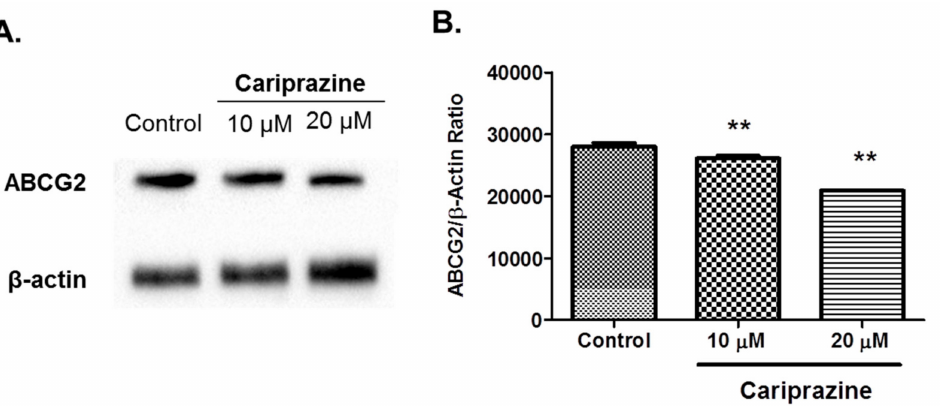
Figure 5. The effects of cariprazine on the expression level of the ABCG2 transporter protein. ( A ) H460-MX20 cells were incubated with 10 or 20 µ M cariprazine, respectively. ( B ) The columns represent the mean of the western blot quantification values. The error bars represent the SEM. At least two additional experiments showed similar results to the representative figure results. ** p <